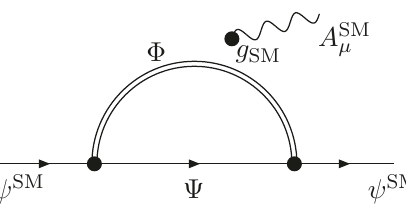
Figure 1 . One loop contribution to the dipole operator of the SM fermions. The external A field can be inserted in the fermionic or bosonic propagator. Ψ is a heavy fermion, Φ can be either a Higgs or a gauge boson. The couplings in the vertices can be gauge, Yukawa or d